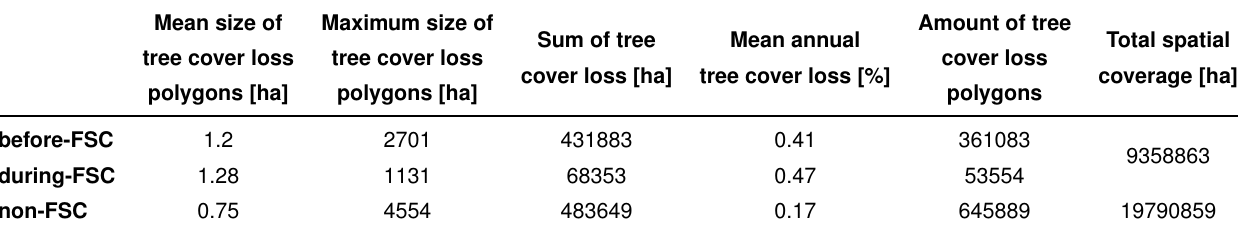
Table 5. Tree cover loss inside (before-FSC: before FSC certification was issued; during-FSC: while FSC certification was valid) and outside (non-FSC) of FSC-certified logging